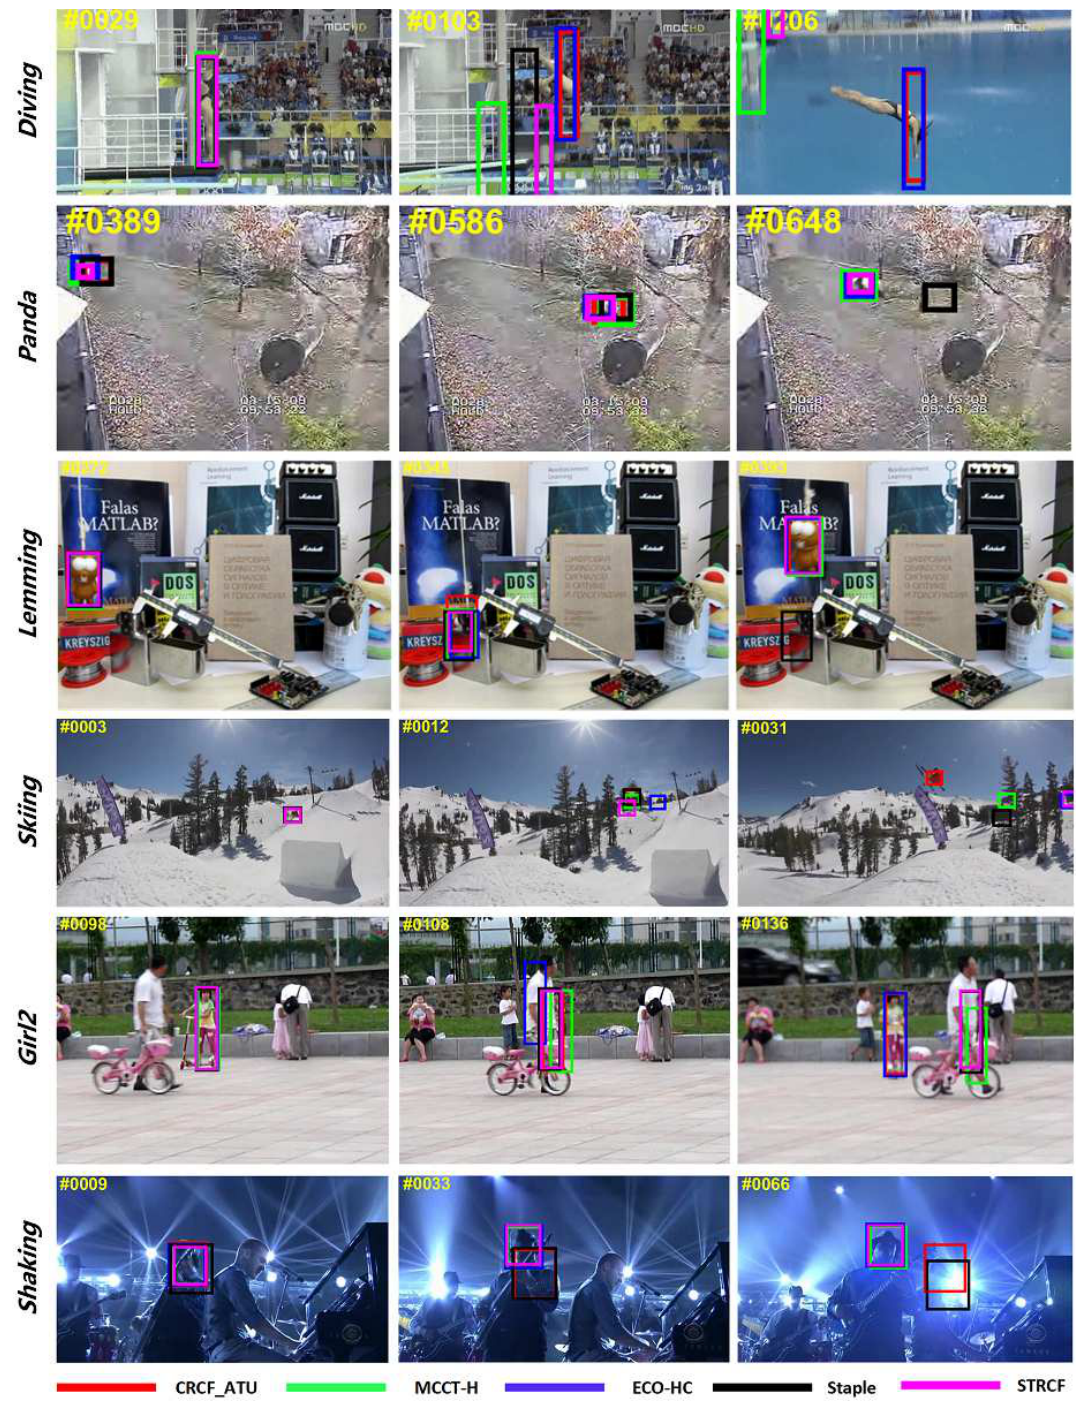
Figure 12. Tracking result visualization of our proposed CRCF_ATU tracker and comparative trackers on sequences Diving, Panda, Lemming, Skiing, Girl2,